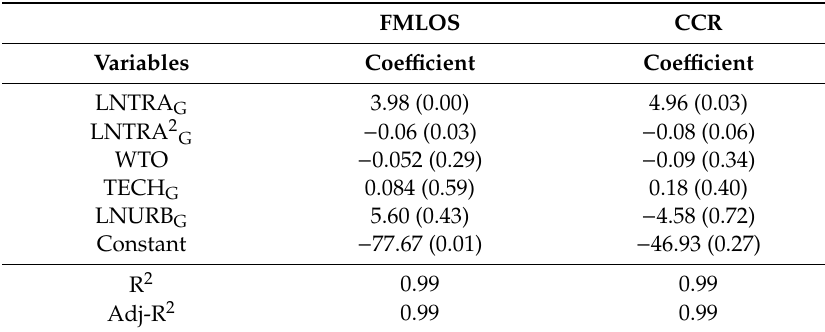
Table 13. Robustness analysis for Model